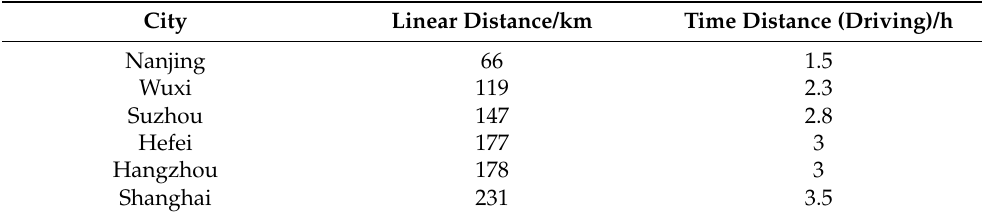
Table 3. Time and space distance between Shishanxia village and major cities in the Yangtze River Delta (Data from Baidu Map)